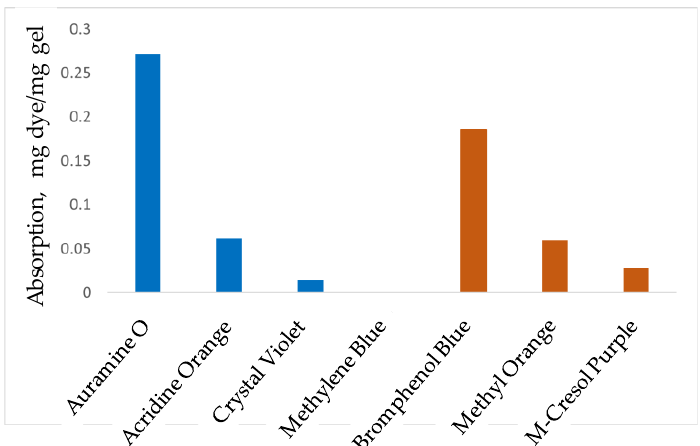
Figure 14. Binding of cationic (blue bars) and anionic (orange bars) dyes in a PSt- l -VBzGG-7 10 wt% gel. See ‘Materials and Methods’ for test conditions.